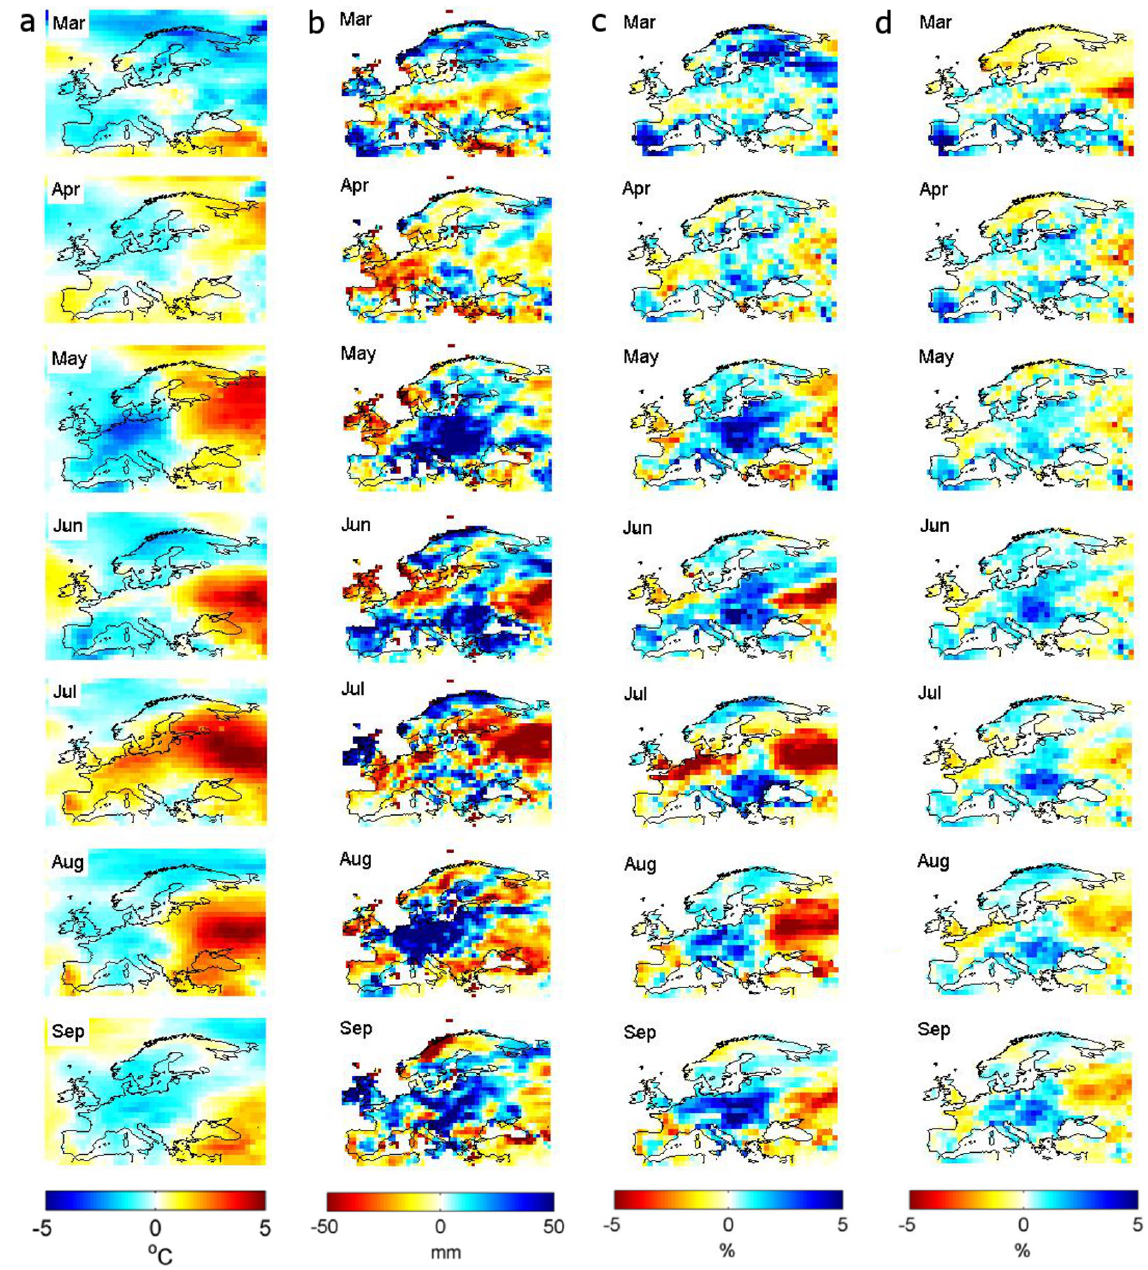
Figure 8. As in Fig. 7, but for